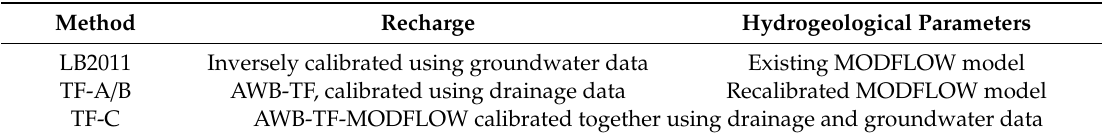
Table 1. Methods tested for model integration.